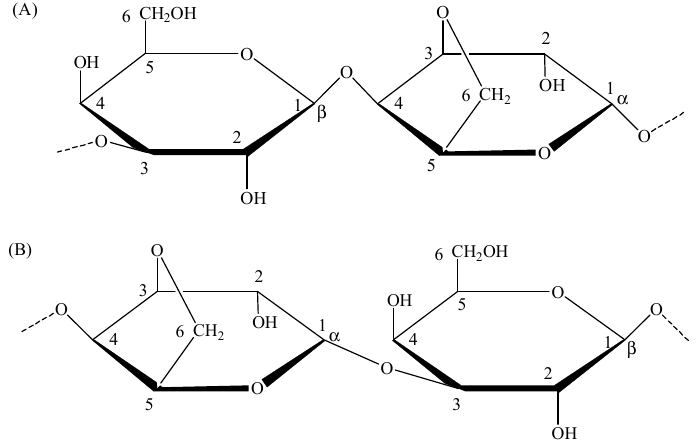
Figure 1. Structure of agarobiose ( A ) and neoagarobiose ( B ).